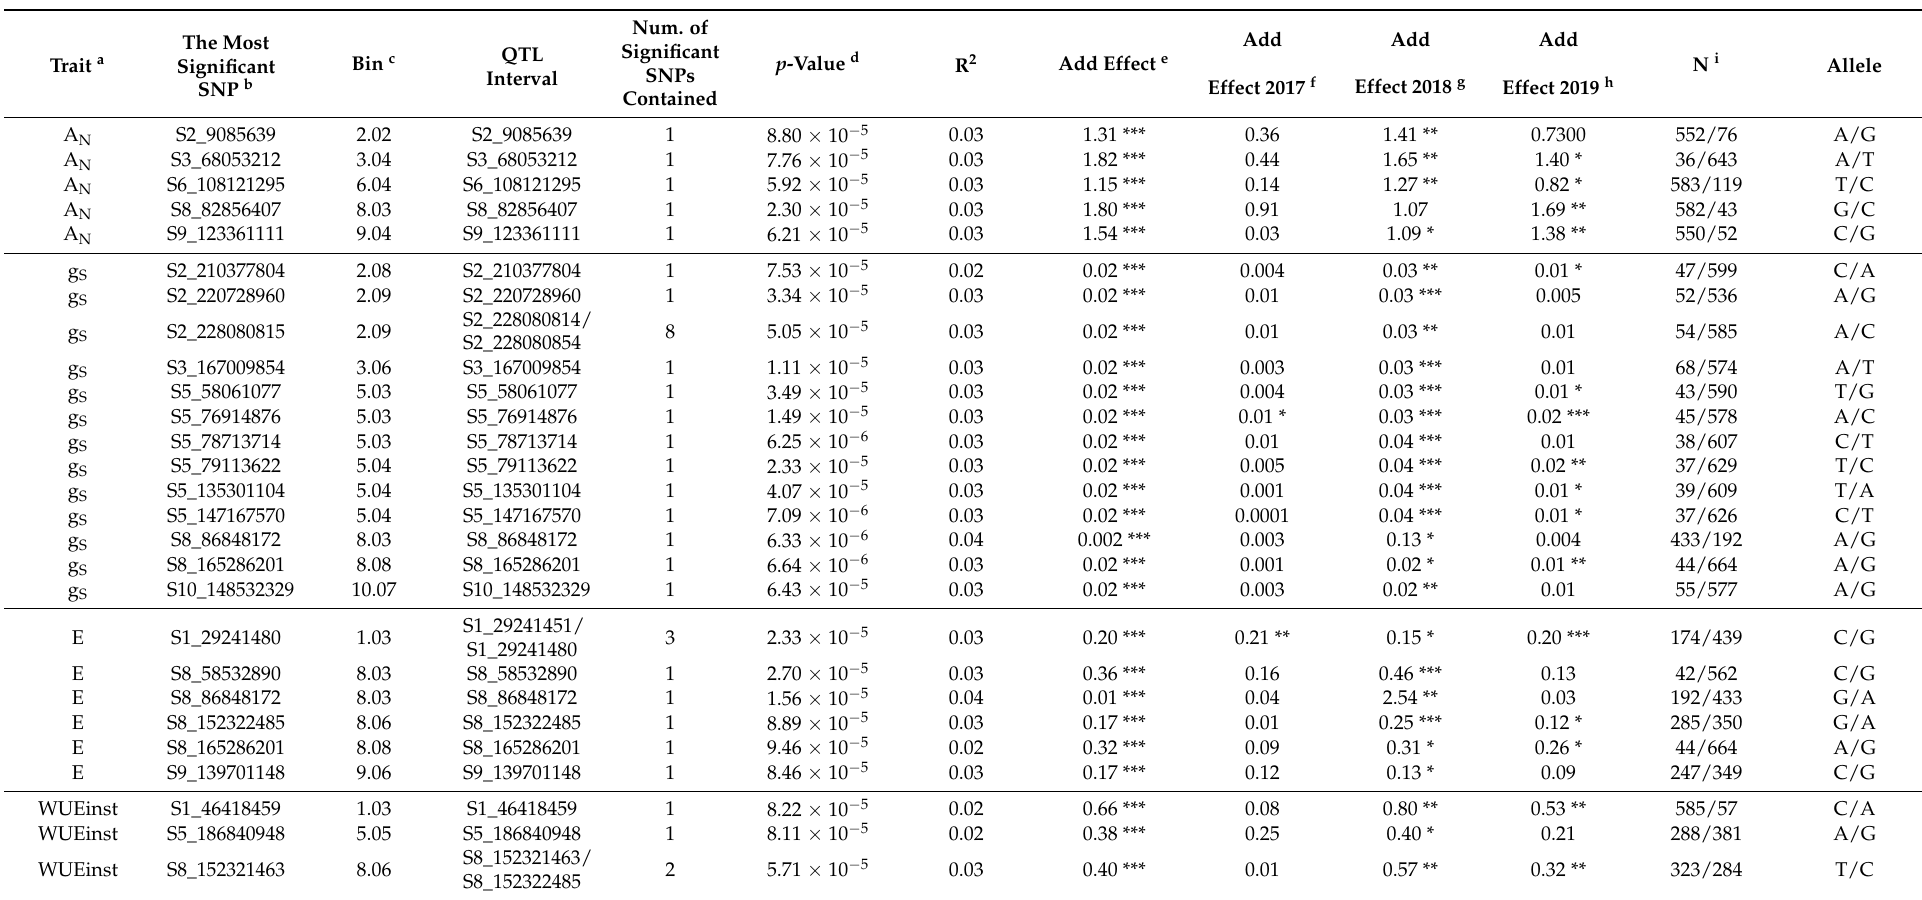
Table 4. The characteristics of SNPs most significantly associated to photosynthetic traits within each QTL: bin, p -value, proportion of total variance explained by the SNP (R 2 ), additive effect (across years, 2017, 2018, 2019), and number of lines of the maize association panel homozygous for each